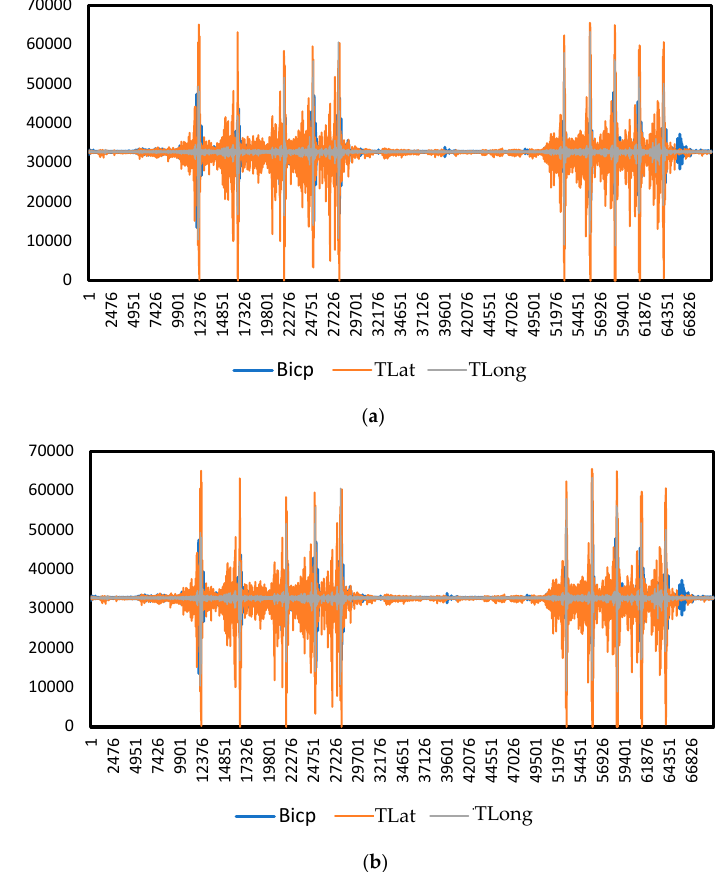
Figure 5. sEMG raw signal for one of the athletes: ( a ) Duora 33; ( b ) Duora 88.